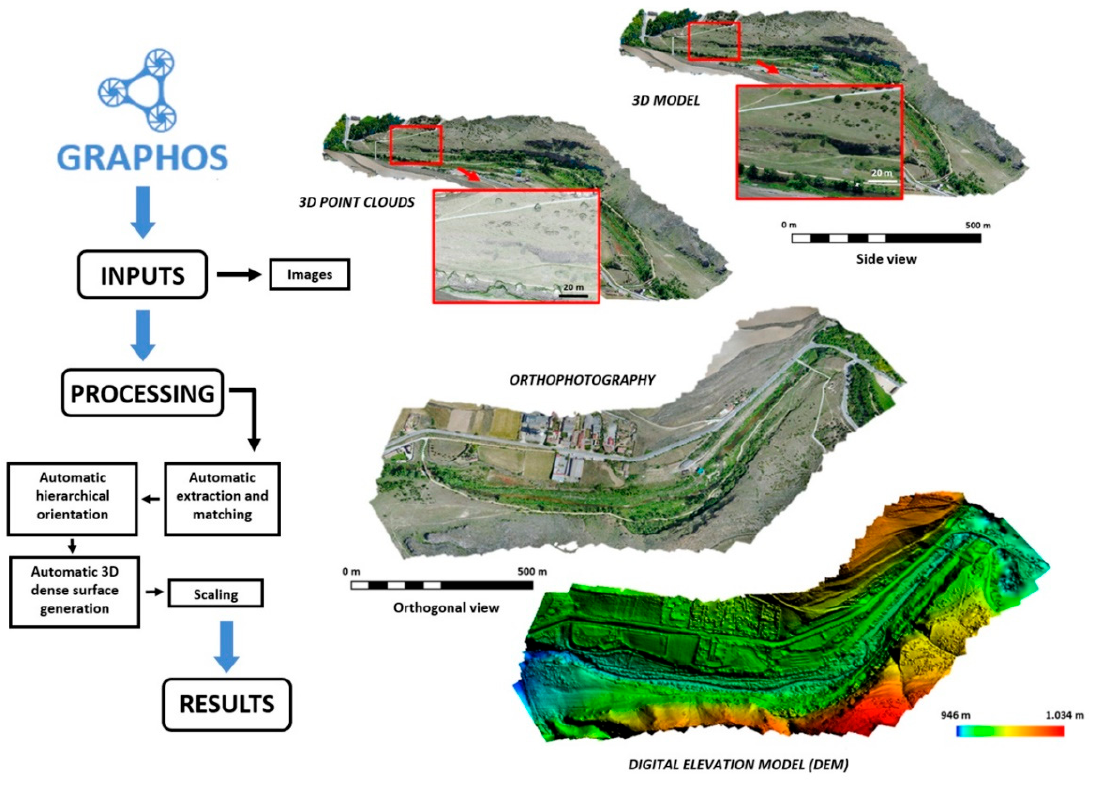
Figure 7. Flow of data processing frames and results with GRAPHOS software.